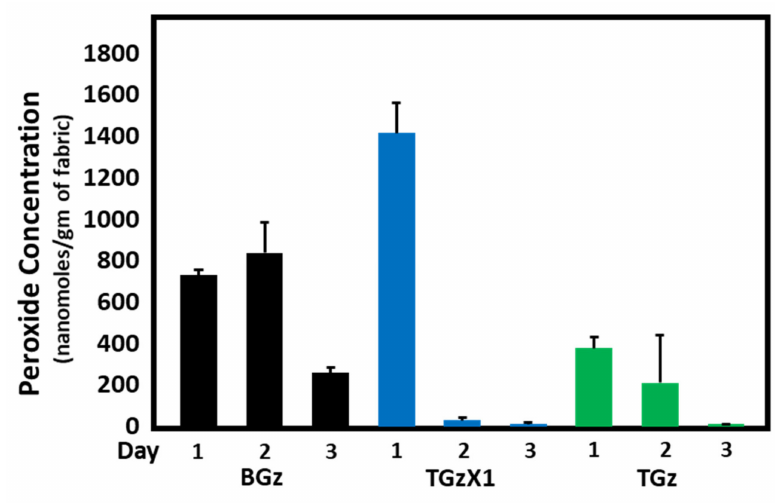
Figure 3. Comparison of hydrogen peroxide accumulation over a three-day period. Fabrics (50 mg) were incubated in H 2 O (2.5% weight/volume) at room temperature for 1, 2, and 3 days. Aliquots were removed and H 2 O 2 content determined using the ferrous oxidation-xylenol assay, n = 4. Error bars represent SEM. ANOVA (Tukey) revealed that the levels of H 2 O 2 generated by BIOGauze (BGz) were significantly higher on Day 2 compared to the those of the other two fabrics. Even though the peroxide levels generated with BGz declined significantly on Day 3, it was significantly higher than those of either the TGzX1, TACGauze acid-crosslinked treatment or the TGz, TACGauze untreated fabric, whose peroxide levels had fallen to essentially